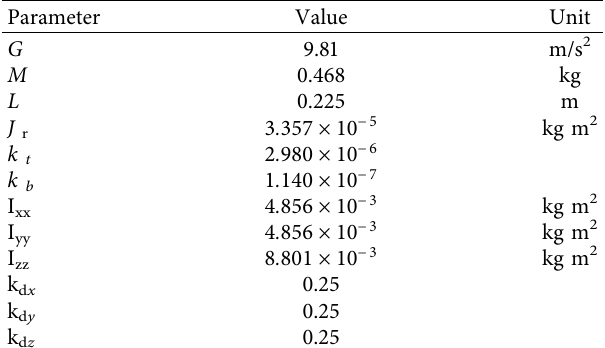
Table 1: Quadcopter parameter values for simulation. Table 2: Initial conditions for simulation.